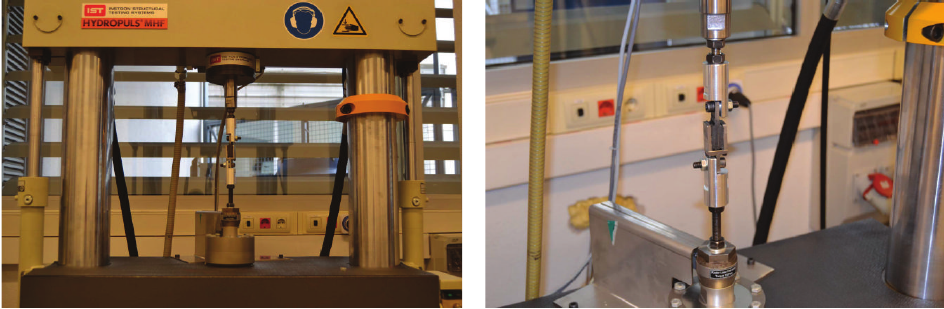
Figure 3: INSTROM Hydropuls MHF 25 L test equipment.